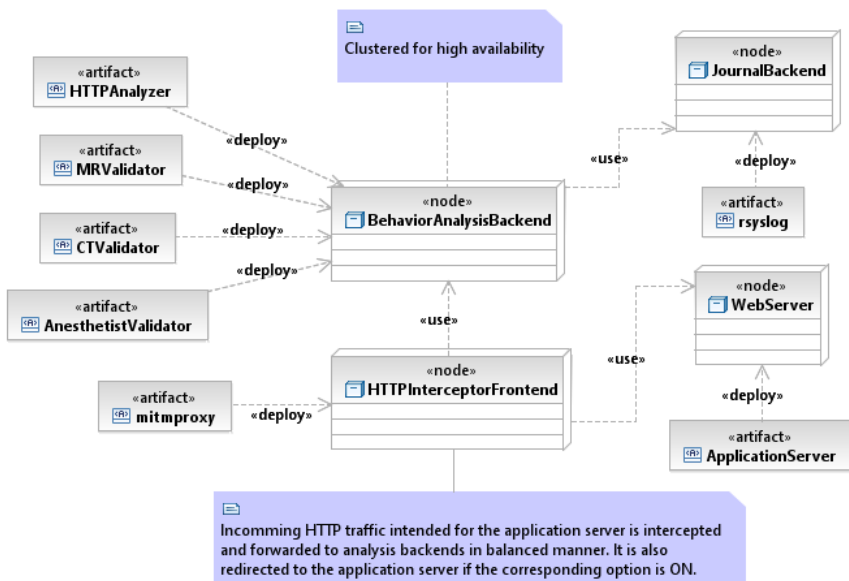
Figure 7. Deployment diagram of the subsystem for analysis of users’